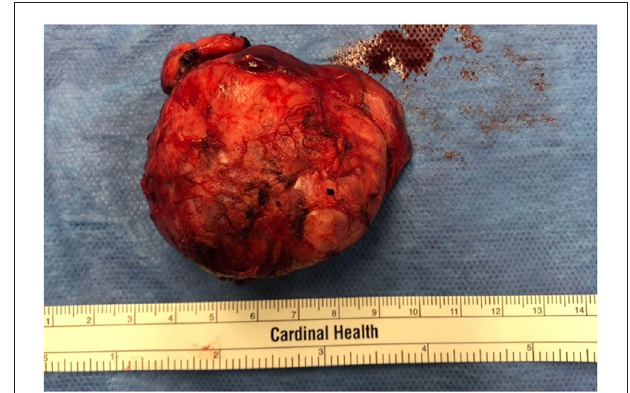
FIGURE 3 | Gross surgical specimen. The nodal mass was completely